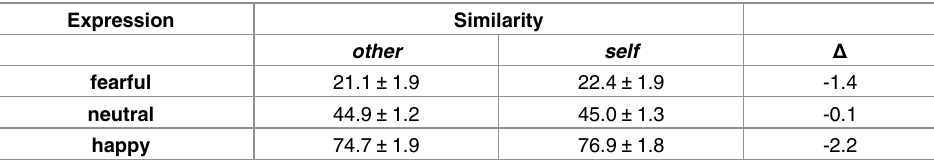
Table 2. Mean ratings of valence (Exp. I).